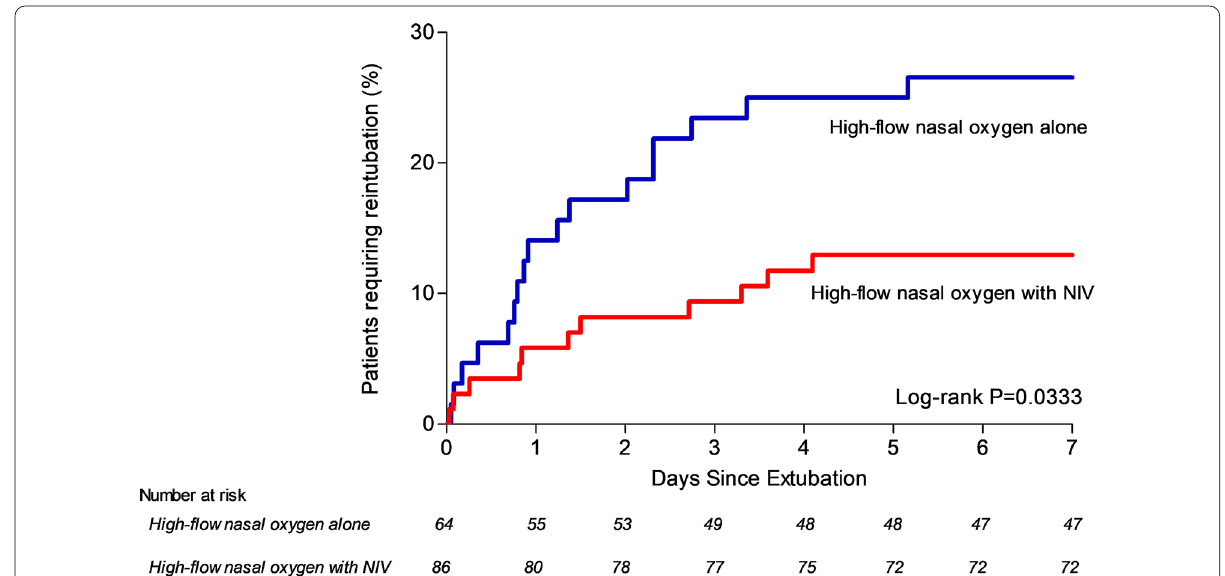
Fig. 1 Kaplan–Meier analysis of time from extubation to reintubation according to oxygenation strategy. Reintubation rates were significantly lower in patients treated with non‑invasive ventilation (red bars) than in those treated with high‑flow nasal oxygen alone (blue bars). The reintubation rate within the 7 days following extubation was 13% (11 out of 86 patients) with NIV and 27% (17 out of 64 patients) with high‑flow nasal oxygen alone